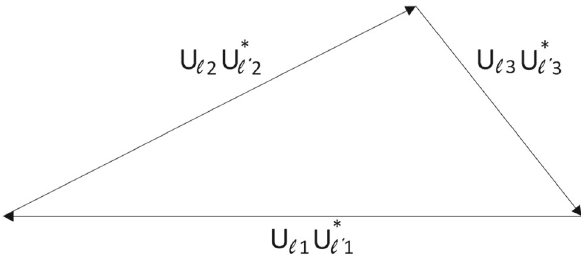
Fig. 5 Schematic representation of a unitarity triangle